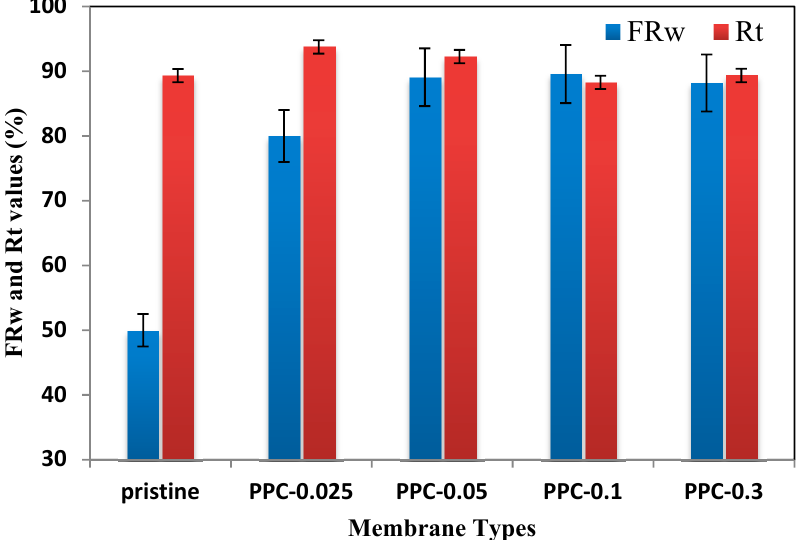
Figure 14. Total fouling ratio and Flux recovery for pure PVDF and resultant membranes.